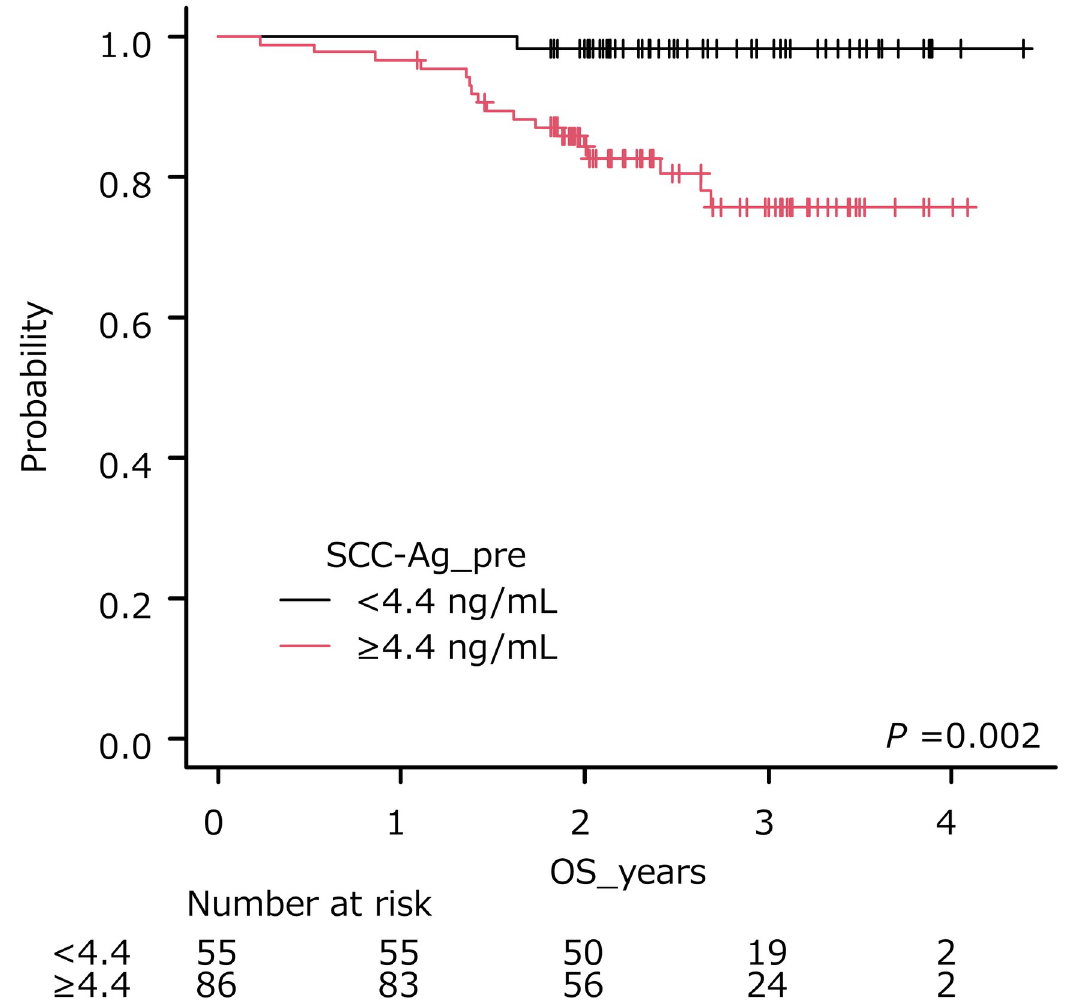
Fig 3. Overall survival of patients stratified by pretreatment SCC levels. Higher levels of pretreatment SCC-Ag ( > 4.4 ng/ml) were significantly associated with poorer outcome ( P =